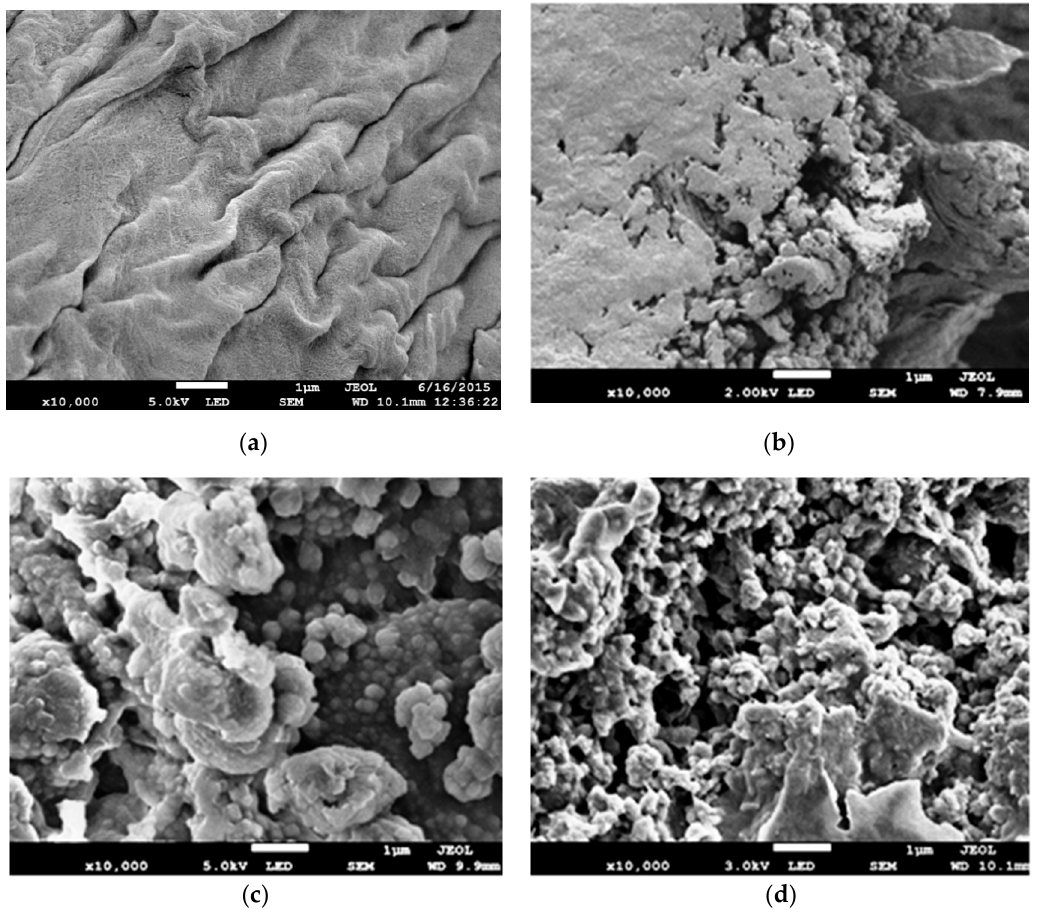
Figure 4. FE-SEM micrograph of ( a ) jute cellulose, ( b ) PAN-grafted cellulose, ( c ) poly(amidoxime) ligand, and ( d ) poly(amidoxime) ligand-copper complex.